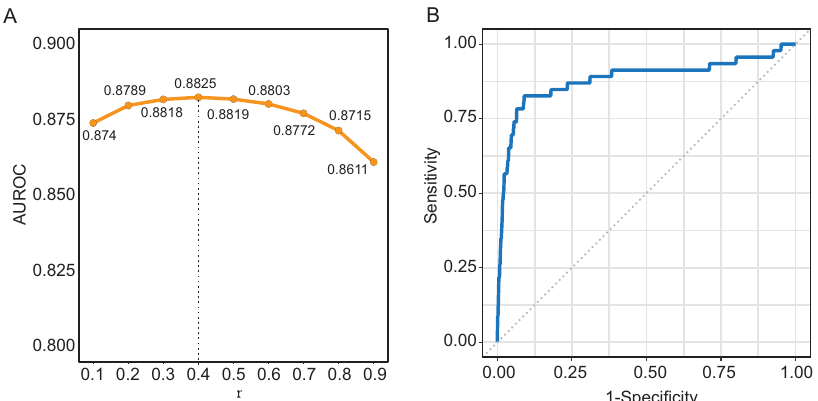
Fig. 2 Performance evaluation of the iUMRG. A AUC values of r under each LOOCV. B Receiver operating characteristic curves of iUMRG under LOOCV based on 59 experimentally supported UM-related susceptibility genes. AUC receiver operating characteristic curve, UM uveal melanoma, LOOCV leave-one-out